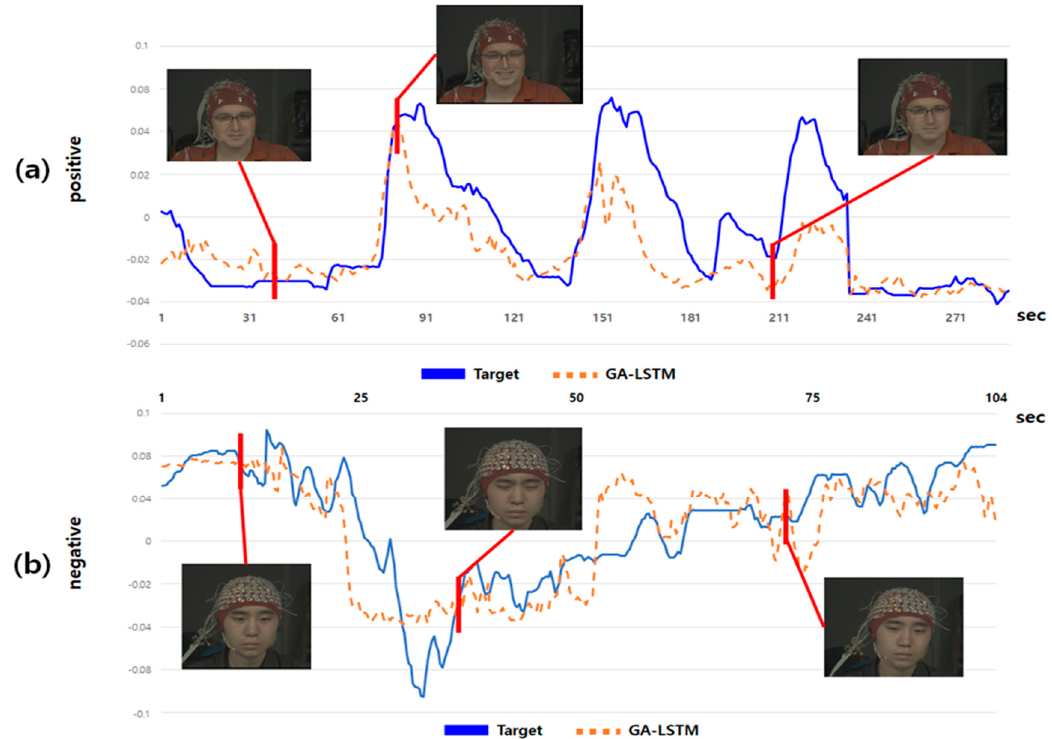
Figure 8. Example of the MAHNOB-HCI test result. ( a ) Positive valence, ( b ) negative valence.